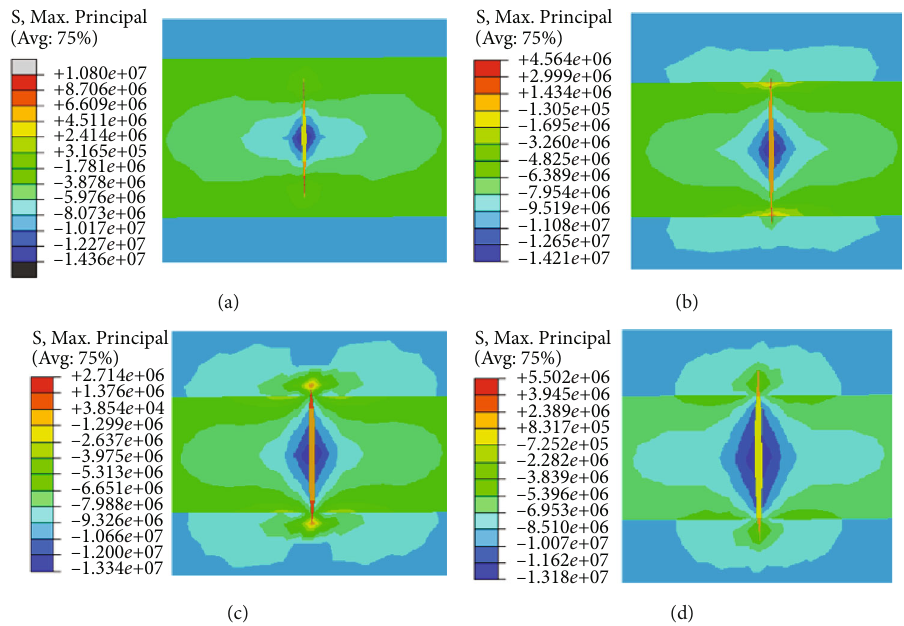
Figure 21: E ff ect of viscosity on the development of hydraulic fracturing height for a range of temperature from 80 ° C to 120 ° C of the layers and at di ff erent times: (a) 10 steps, (b) 20 steps, (c) 40 steps, and (d) 50